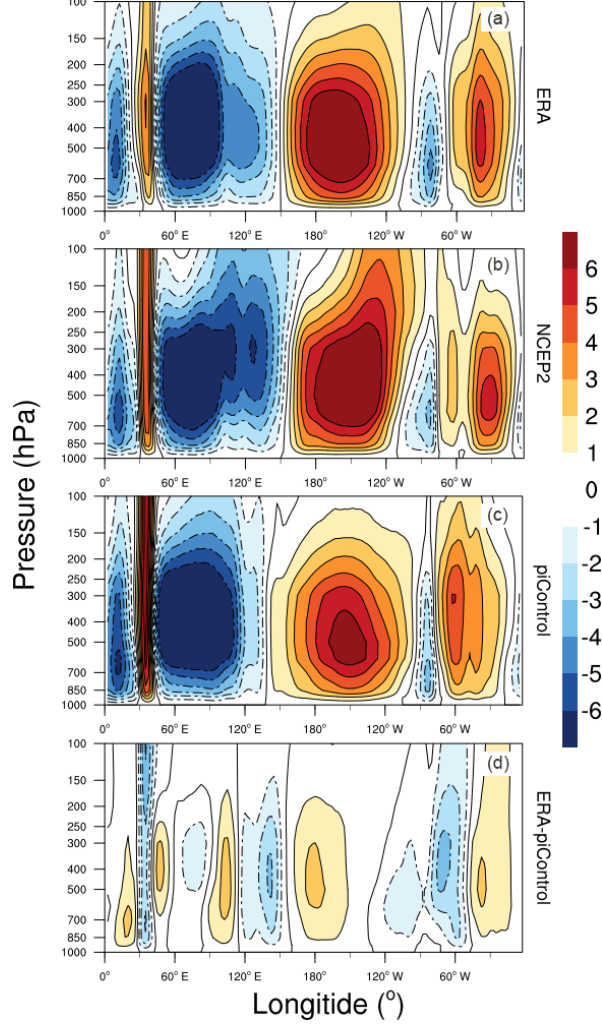
Figure 1. Walker circulation in the ERA-Interim reanalysis (a) , NCEP2 reanalysis (b) , model ensemble mean under piControl (c) and difference between ERA-Interim and piControl (d) . Color bar indicates the value of averaged zonal mass stream function (10 10 kgs − 1 ). Warm colors (positive values) indicate a clockwise rotation and cold colors (negative values) indicate an anticlockwise